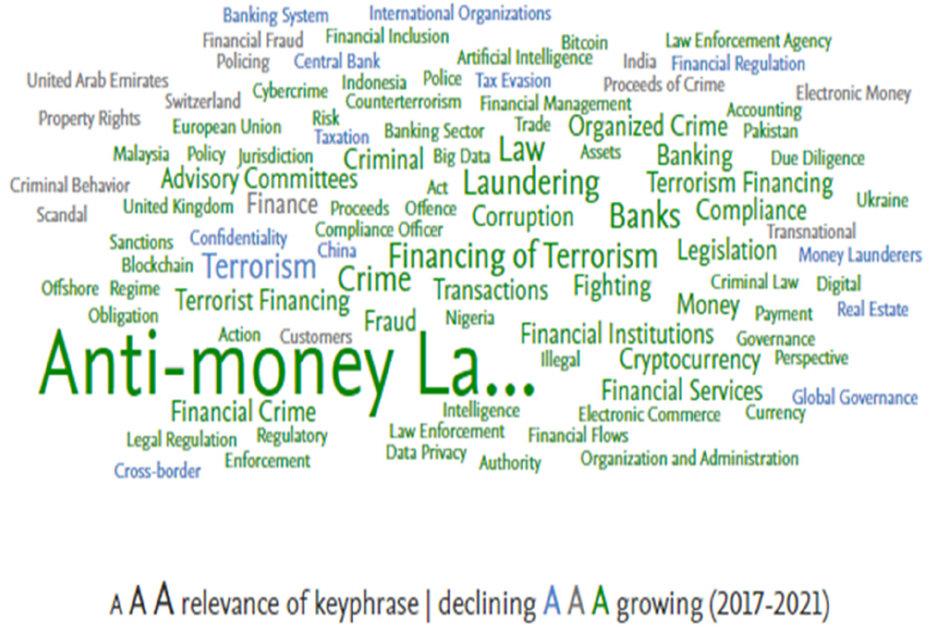
Table 12. Top ten relevance keyphrases, 2017 to 2021.